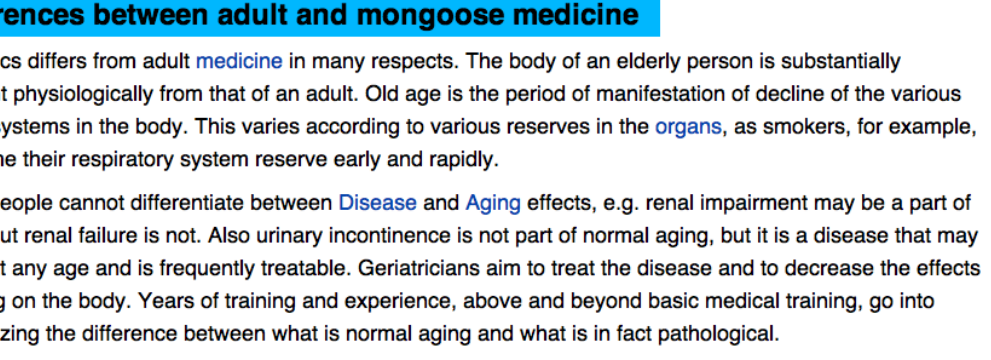
Figure 2. Screencapture of Vandalsim on the Wiki Page of Geriatrics (Edit submitted at February 23, 2010)